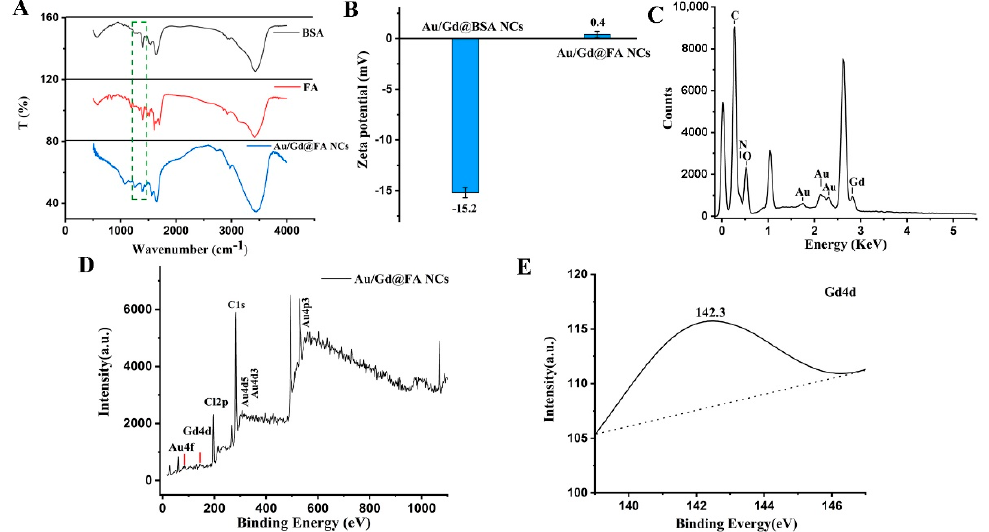
Figure 2. ( A ) FT-IR spectra of BAS, FA, and Au/Gd@FA NCs. ( B ) Zeta potential of Au/Gd@BAS